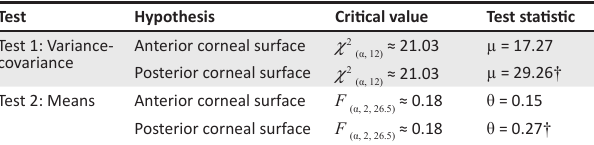
TABLE 3: Hypothesis tests done on variance-covariance matrices and means for the anterior and posterior corneal surfaces. Test Hypothesis Critical value Test statistic Test 1: Variance- Anterior corneal covariance